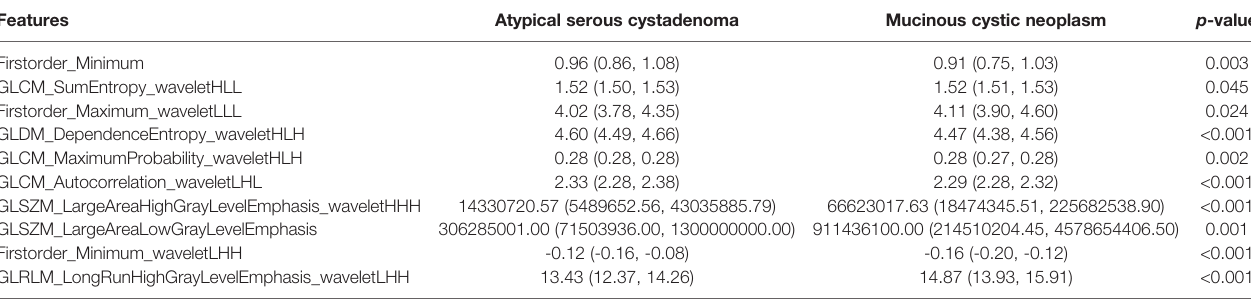
TABLE 3 | Comparisons of 10 optimal radiomics features in distinguishing between mucinous cystic neoplasm and atypical serous cystadenomas. Features